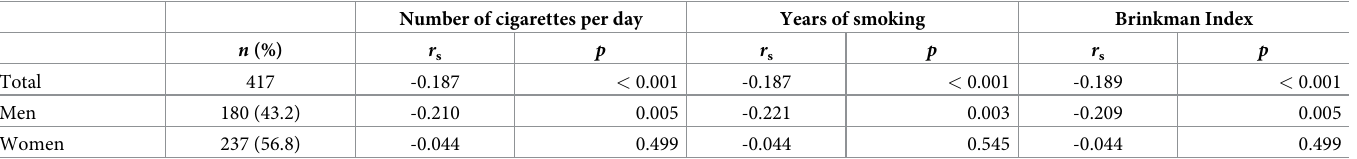
Table 2. Spearman’s rank correlation coefficients for the associations between TXNIP DNA methylation levels and smoking status. Number of cigarettes per day Years of